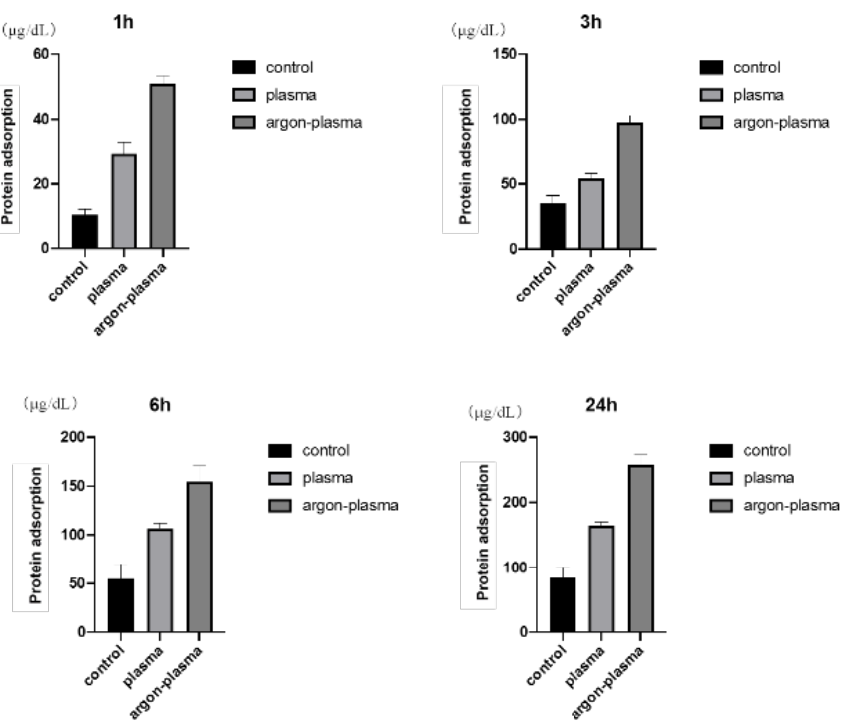
Figure 3. The results of the adhesion examination of BSA among the three groups are shown. The BSA adsorption was significantly higher in the test group than in the control group. In addition, the highest value was observed in the group modified with argon plasma.